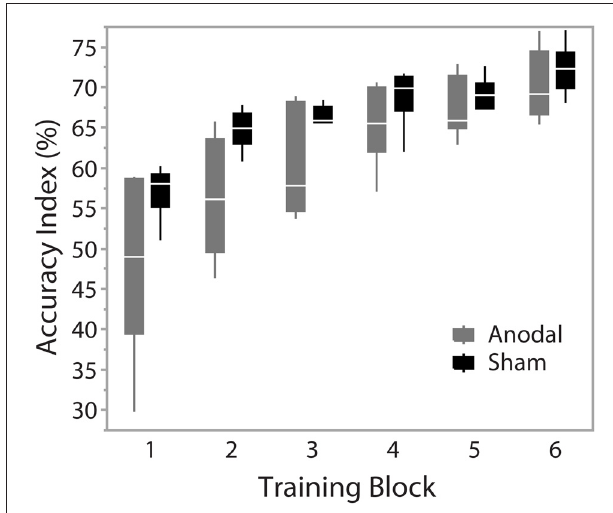
FIGURE 2 | Accuracy across training blocks. Blocks 1–6 represent training blocks with simultaneous cerebellar tDCS. A 5-min rest period was given between block 3 and 4. Data are median and range with 95% confidence intervals.